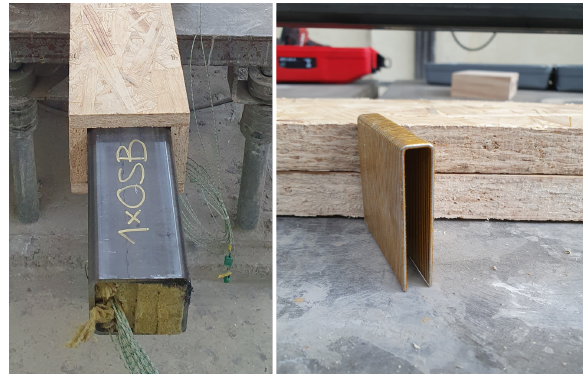
Figure 4. Photo of the beam #2 with one layer of OSB protection (left) and the 50 mm narrow crown staples (right).